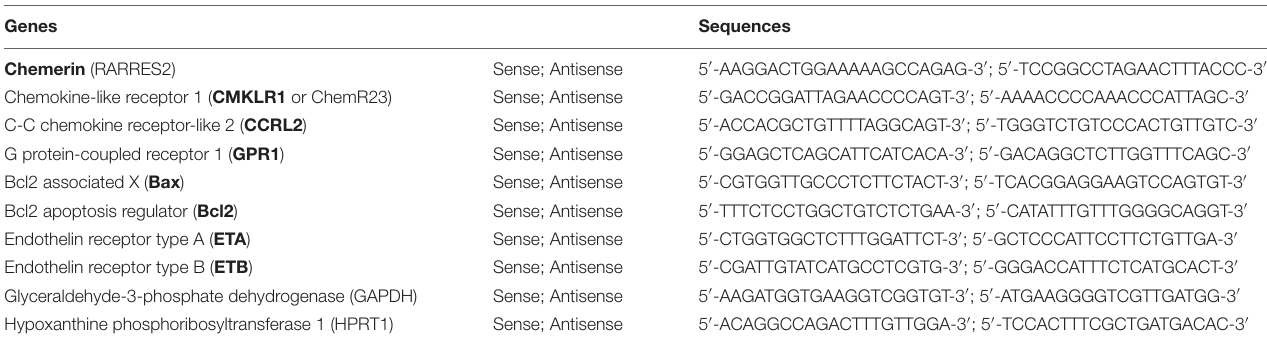
TABLE 1 | Primers used for real-time quantitative polymerase chain reaction (RTq-PCR) in rattus norvegicus samples.